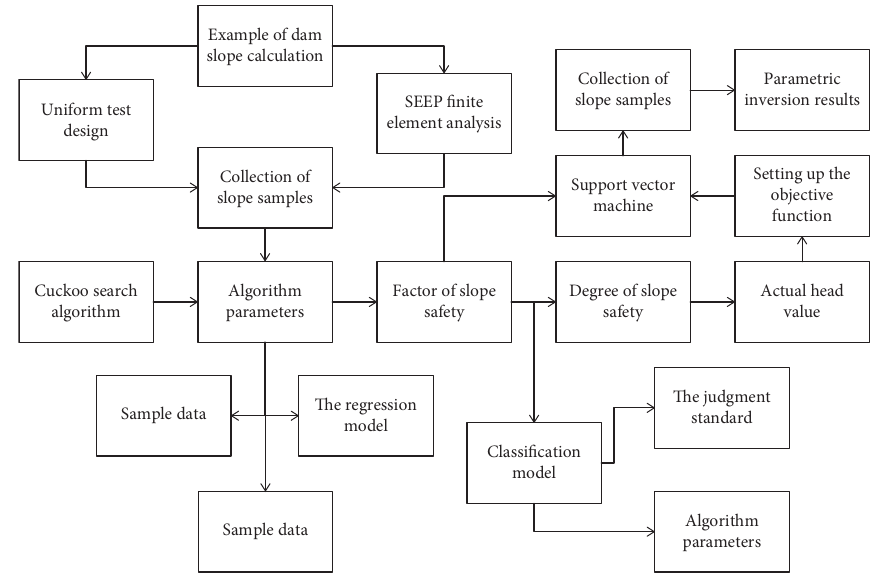
Figure 1: The technical route of this paper.